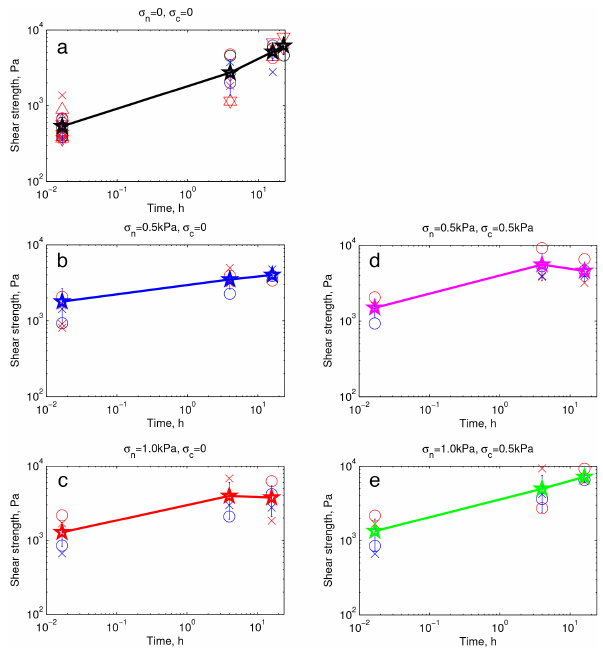
Figure 2. Shear strength evolution with sintering time for all sam- ples and all loading conditions (means are indicated by stars and connected by lines; error bars show standard deviations for avail- able measurements: different marker shapes correspond to differ- ent specimens; samples of the same snow type have the same colour). (a) Baseline tests with no external normal pressure, and no preloading ( σ n,c = 0); (b) and (c) with σ n = 0 . 5 or 1.0kPa, respec- tively; σ c = 0. (d) and (e) with σ n = 0 . 5 or 1.0kPa, respectively and σ c = 0 . 5kPa.